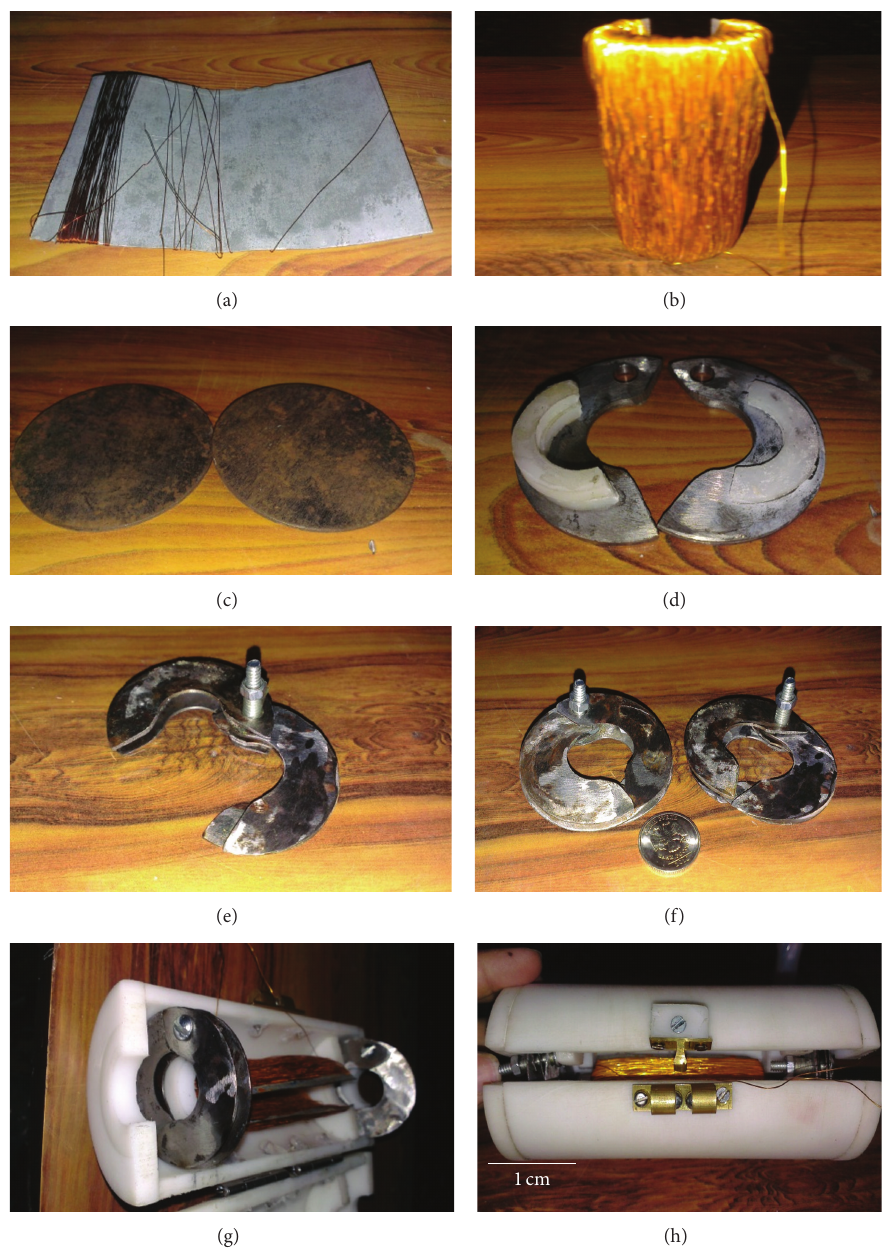
Figure 13: Fabrication of the prototype-5: (a) copper wire wrapping around a mild steel sheet, (b) inductive energy harvester, (c) conductive plates for capacitive energy harvester, (d) Teflon spacer bonded to the split annular plates, (e) assembled capacitive energy harvester in open position, (f) capacitive energy harvesters in closed position, (g) inductor and capacitive energy harvesters placed in split Teflon housing, and (h) assembled